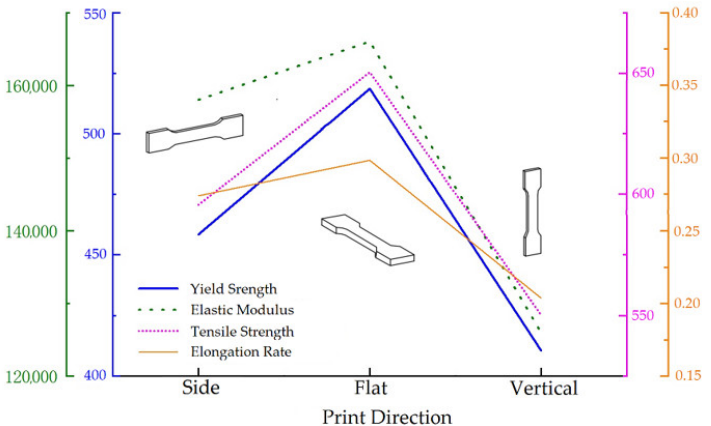
Figure 10. Anisotropy of additively manufactured sample (including yield strength, elastic modu- lus, tensile strength, and elongation) . tensile strength, and